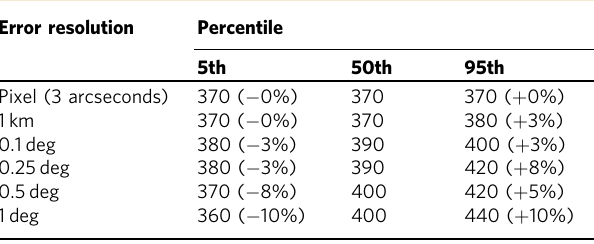
Table 2 Global simulated error assessment results Error